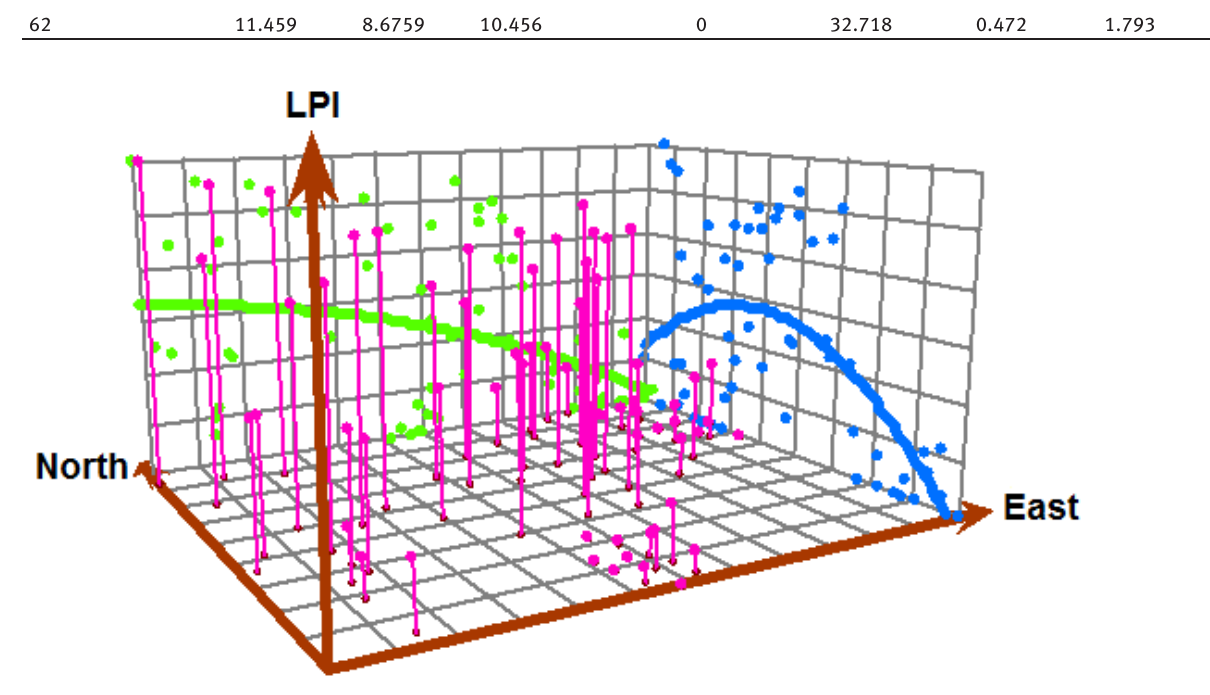
Figure 4: Trend analysis for the liquefaction potential index